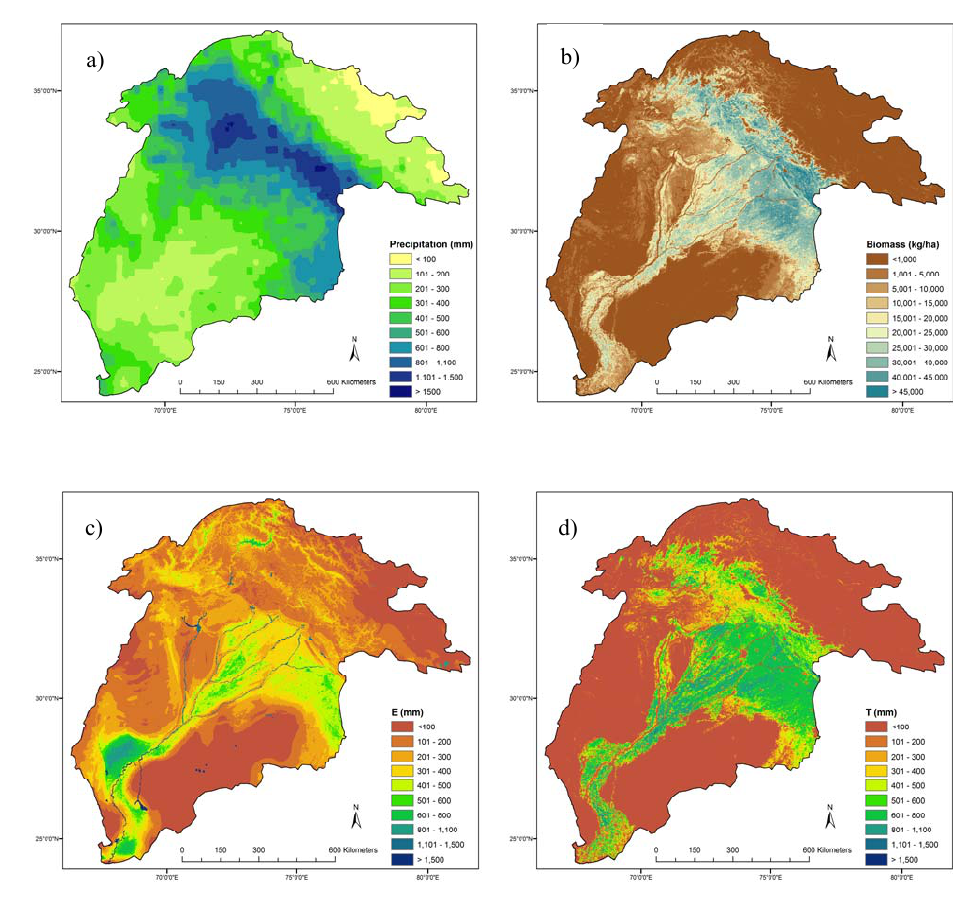
Fig. 2. (a) Precipitation (based on data from Cheema and Bastiaanssen, 2012) (b) biomass production (c) evaporation (d) transpiration (based Figure 2. (a) Precipitation (based on data from Cheema and Bastiaanssen, 2012) (b) Biomass 2 on data from Bastiaanssen et al., 2012) in the Indus basin in production (c) Evaporation (d) Transpiration ( based on data from Bastiaanssen et al. 2012) in 3 the Indus basin in 2007. 4